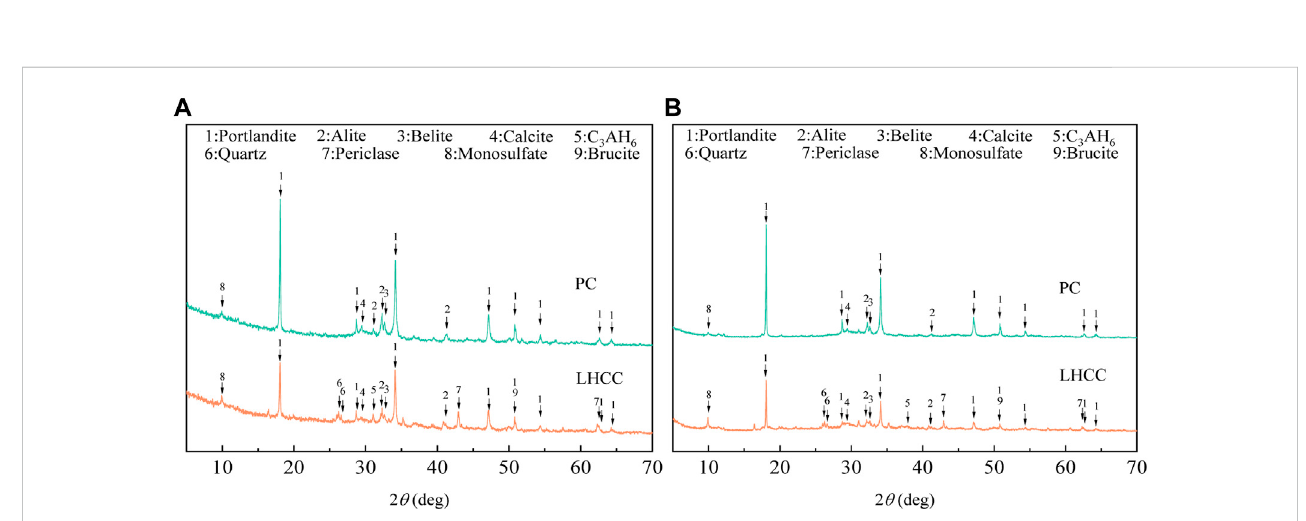
FIGURE 5 XRD spectra of specimens cured for (A) 3 days and (B) 90 days.